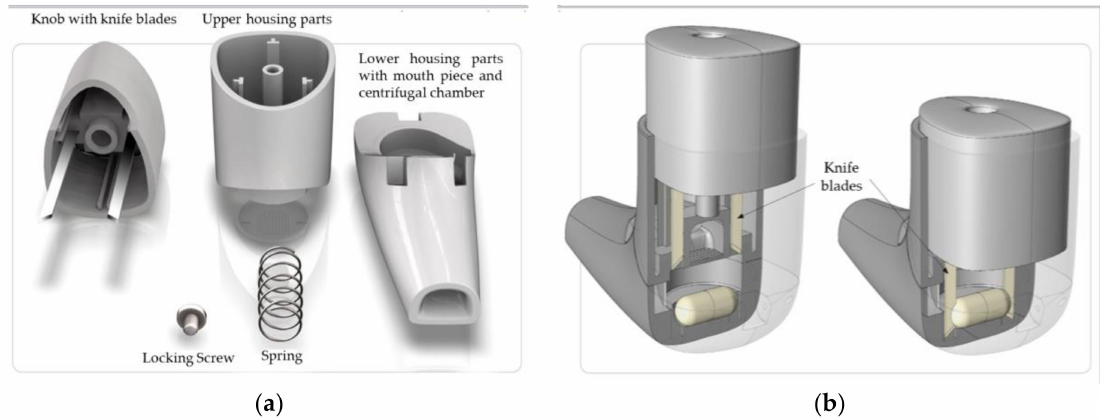
Figure2. ( a )Di ff erentpartsoftheUNI-Halerand( b